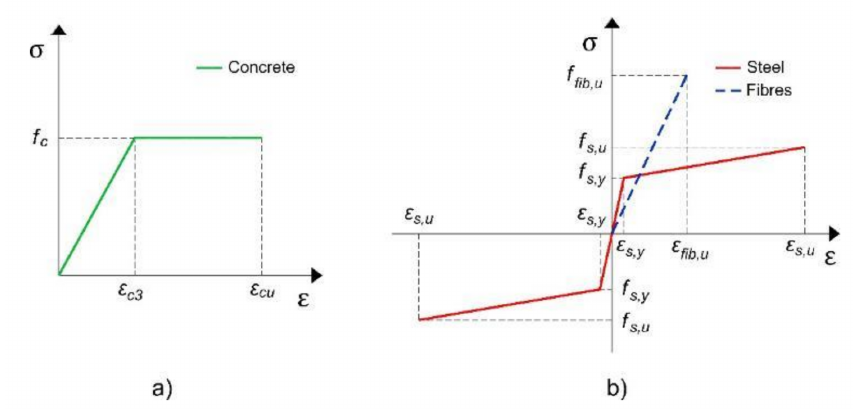
Figure 2. Constitutive behavior of the materials: ( a ) Concrete and ( b ) steel and